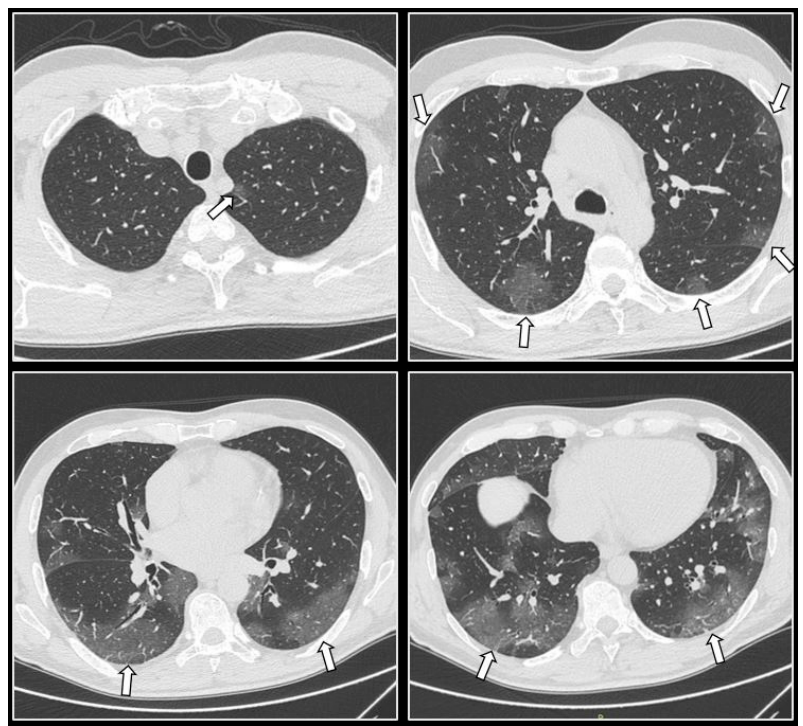
Figure 1. Axial images from a chest CT of a COVID-19 patient demonstrate multiple ground glass opacities (arrows) in both lungs and multiple lobes which are primarily distributed peripherally, posteriorly, and in the lower zones. Opacities occupy approximately 26–50% of the total lung parenchyma according to visual assessment [45].